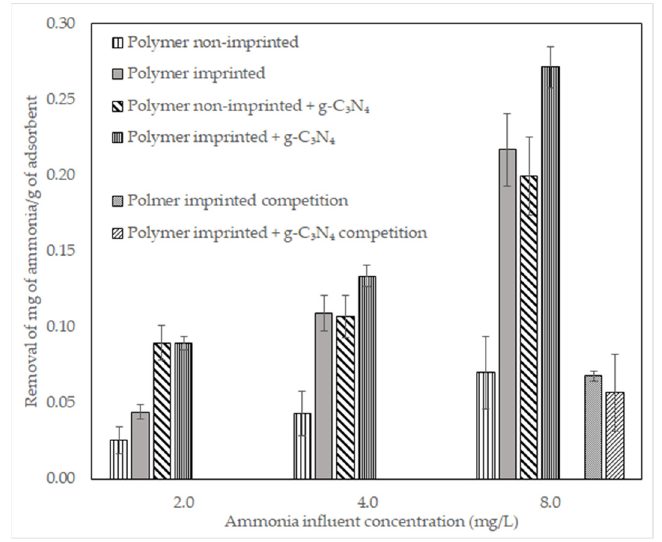
Figure 6. Removal of ammonia in columns by specified materials at different ammonia concentrations in the influent. Imprinted polymer with g-C 3 N 4 performs similarly to other materials but competition experiments show no selectivity.